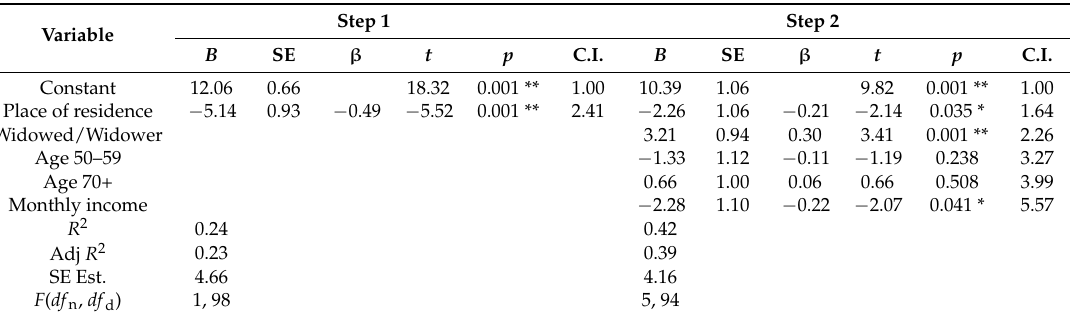
Table 4. Results of the hierarchical regression